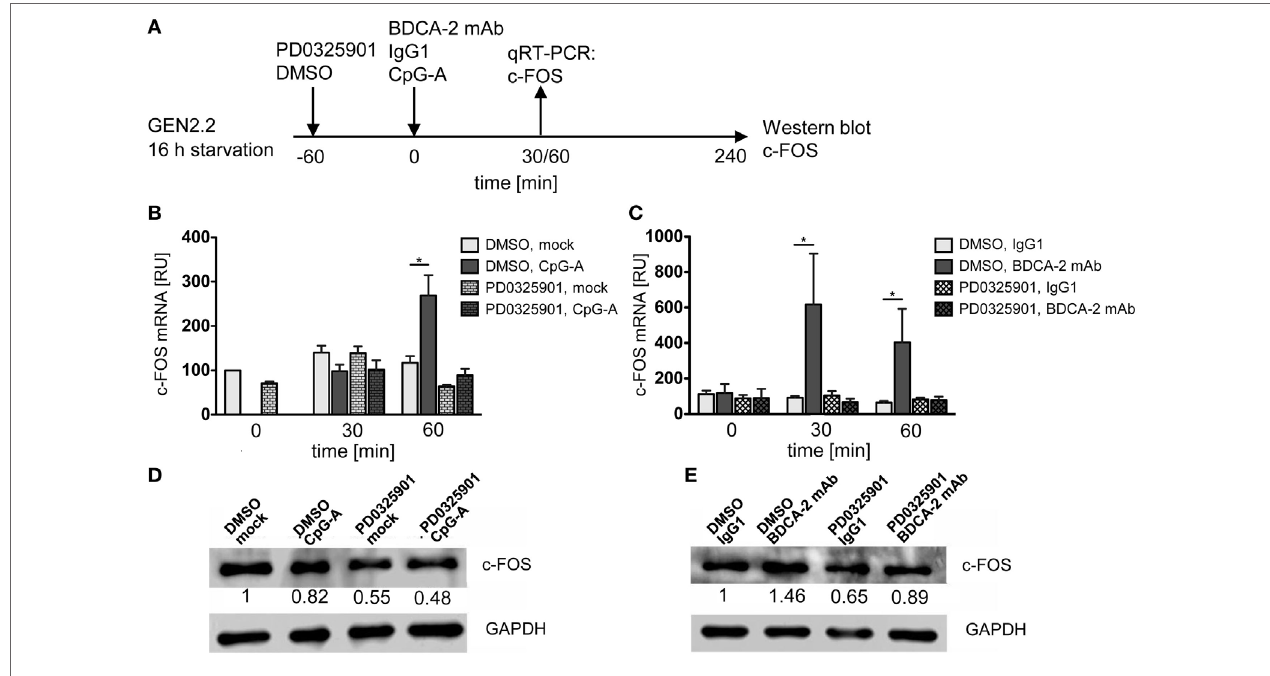
FigUre 8 | c-FOS mRNA and protein expression in GEN2.2 stimulated with TLR9 or RR agonists. (a) Experimental outline. GEN2.2 cells separated from MS-5 feeder cells and starved in a serum-free medium for 16 h were pretreated or not with MEK1/2 inhibitor PD0325901 for 1 h and then exposed to CpG-A (B,D) or blood dendritic cell antigen 2 (BDCA-2) mAb (c,e) . (B,c) The expression of human c-FOS mRNA was quantified after 30 or 60-min exposure to CpG-A (B) or BDCA-2 mAb (c) by TaqMan qRT-PCR in the total cellular RNA. The data normalized to time zero show mean ± SEM of three independent experiments; *, p < 0.05; two-tailed Mann–Whitney test. (D,e) c-FOS protein levels were determined after 240 min exposure to CpG-A (D) or BDCA-2 mAb (e) in the total cell extract by Western blotting by rabbit polyclonal Ab c-FOS (sc-52). Relative quantity of c-FOS protein normalized to mock-treated GEN2.2 cells determined